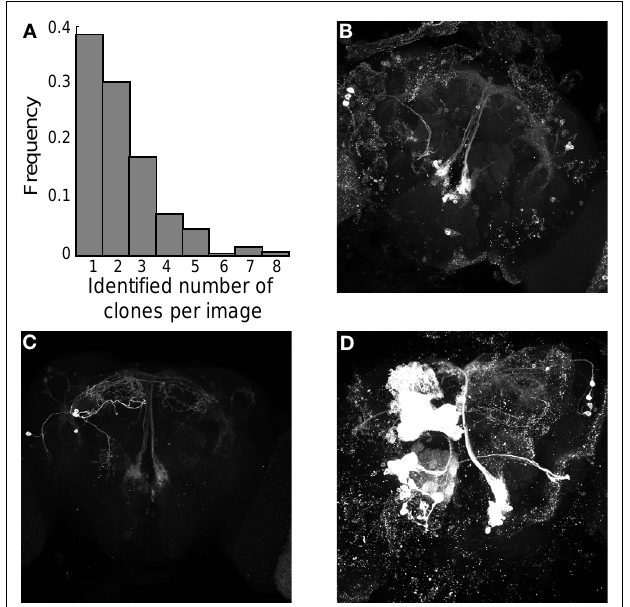
FIGURE 2 | Example images from the dataset. (A) Histogram of the number of identified images per clone. (B) Z-projection of image SAHM16, which contained one identified clone and several unidentified. (C) Z-projection of image SAKW1 which contained two identified clones. (D) Z-projection of image SAJV25 which contained five identified